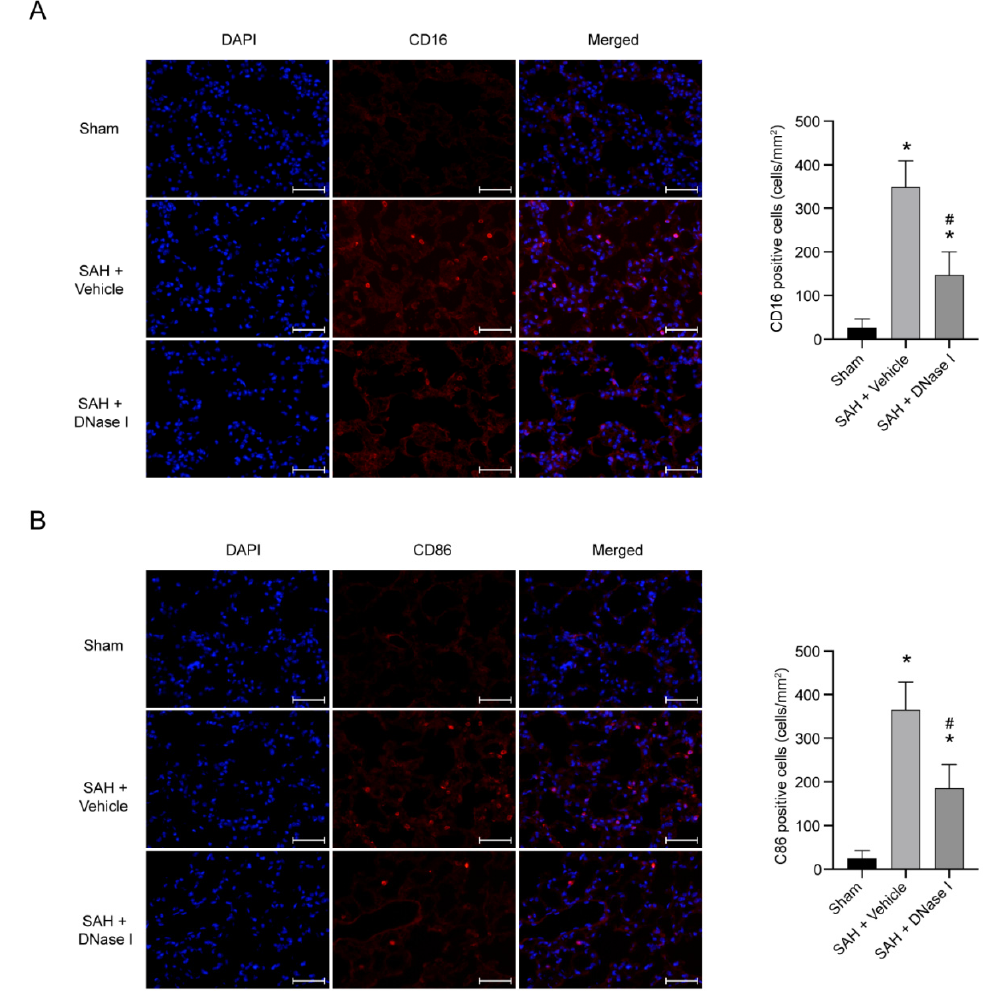
Figure 3. DNase-1 inhibits the proinflammatory transition in NPE after SAH. ( A ) Representative photograph and quantitative analysis of CD16-positive cells (red) among the groups. The nuclei were stained with DAPI (blue). Scale bar = 50 µ m; n = 5/group. ( B ) Representative photograph and quantitative analysis of CD86-positive cells (red) among the groups. The nuclei were stained with DAPI (blue). Scale bar = 50 μ m; n = 5/group. * p < 0.05 versus the sham and # p < 0.05 versus the SAH + vehicle group.